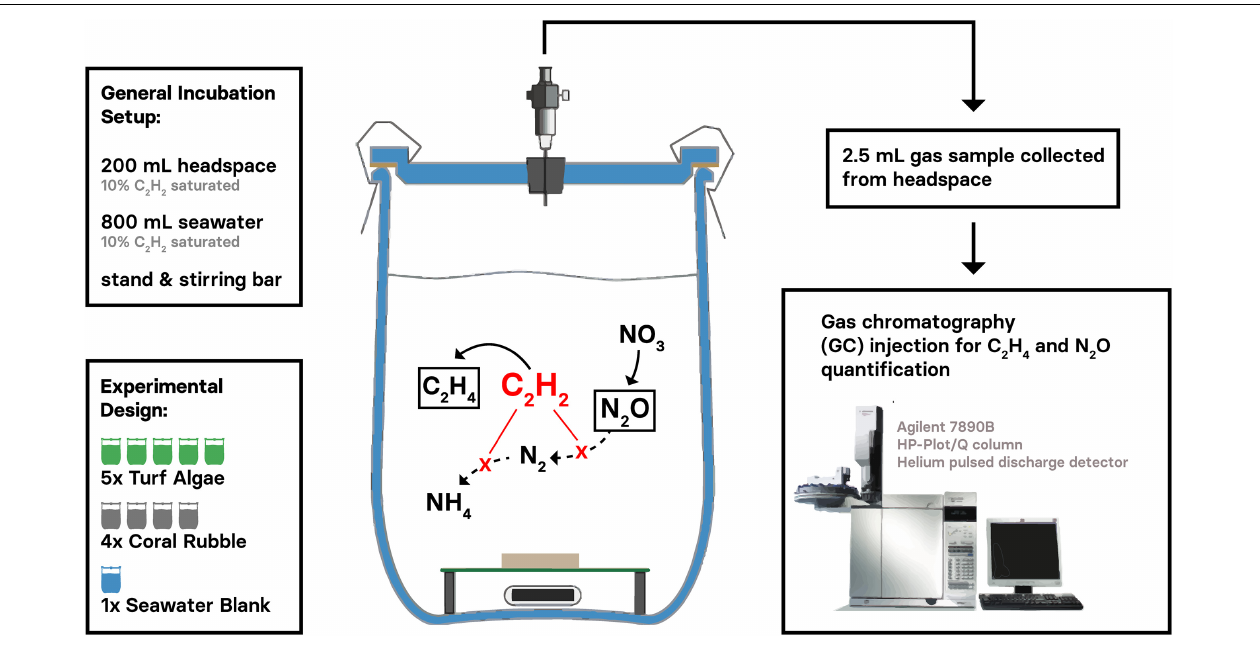
FIGURE 1 | Experimental design and general setup of the CORBA (= Combined Reduction/Blockage Acetylene assay) to simultaneously measure dinitrogen (N 2 ) fixation and denitrification in environmental samples. The two target gases ethylene and nitrous oxide accumulate (framed C 2 H 4 and N 2 O, resp.) as provided acetylene (C 2 H 2 ) is (a) preferentially reduced to C 2 H 4 instead of N 2 to ammonium (NH 4 ), and (b) inhibiting the evolution of in the N 2 gas at the N 2 O-stage. Gaseous samples can be analyzed using gas chromatography.